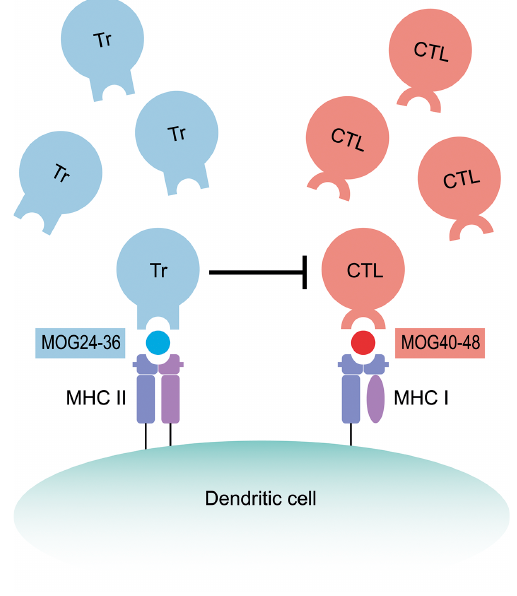
Figure 2. Putative interaction of the immunodominant MOG T cell epitopes. To test the possible interaction of the two MOG T cell epitopes 24–36 and 40–48, we immunized marmoset twins twice (psd 0 and 28) with the long peptide MOG20–50 in which both epitopes were physically linked or with an equimolar mixture of the two short peptides MOG14–36 and MOG34–56 in which the two epitopes were on separate molecules (non-linked). All mon- keys were challenged twice (psd 56 and 84) with an encephalito- genic dose of MOG34–56. The adjuvant was in all cases IFA. All twin siblings (3 / 3) immunized with the non-linked epitopes devel- oped clinically evident EAE, while two of three siblings immunized with the linked epitopes were resistant to EAE. The message of this figure is that T regulator cells (Tr1) specific for MOG24–36 and T effector CTL may need to interact during their reactivation by the same